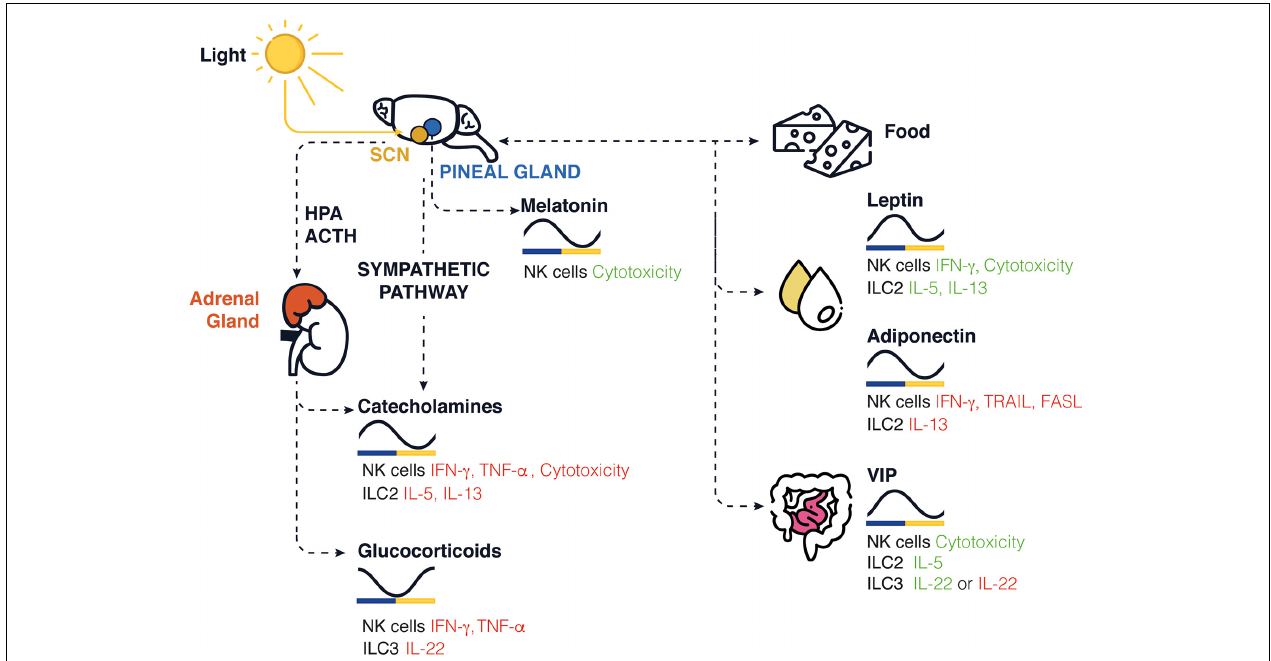
FIGURE 1 | Schematic representation of circadian clock-mediated control of innate immune cells in rodents. In the brain, the SCN controls the rhythmic expression of GCs and catecholamines released in periphery, while the pineal gland controls the release of melatonin. The SCN controls the daily feeding/fasting (activity/rest) cycles, whereas food intake, stress hormone, sleep, and locomotor activity entrains and synchronizes peripheral clocks and the local release of neuropeptides such as leptin, adiponectin, and VIP. The levels found in nocturnal rodents for each molecule are shown across a 24-h period. Green/red represents an increase/decrease in cytokine production or cytotoxicity